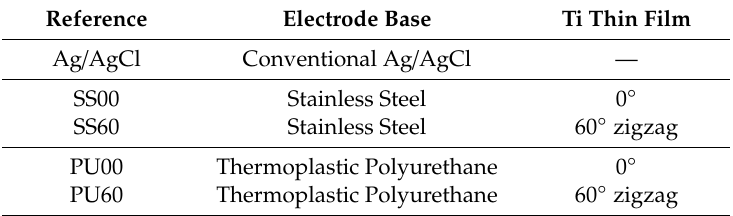
Table 1. Reference of the selected electrodes tested on each volunteer.